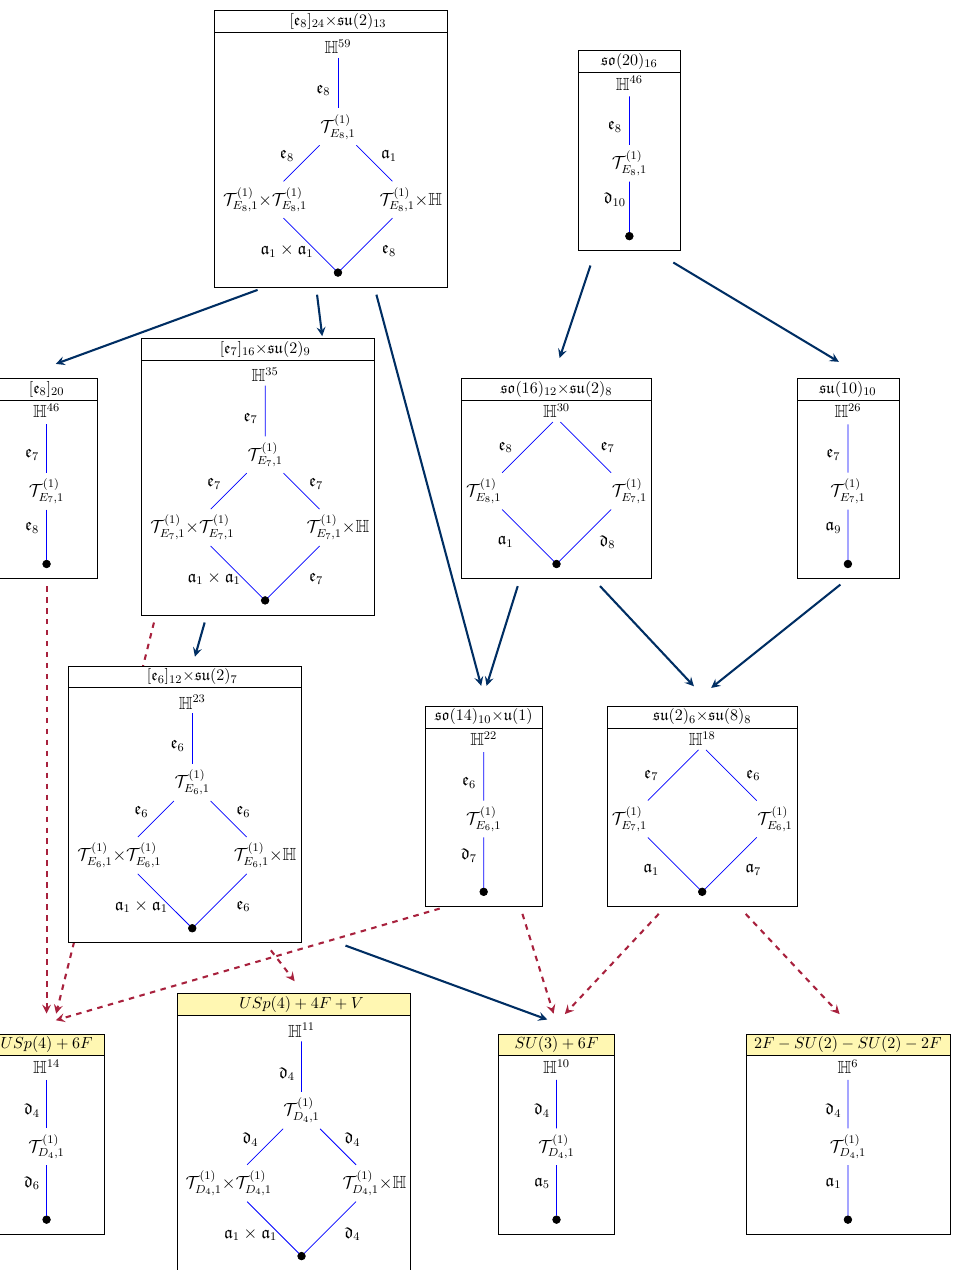
Figure 5 . Higgs branch analysis of the mass deformations among the entries of the e 8 − so (20)